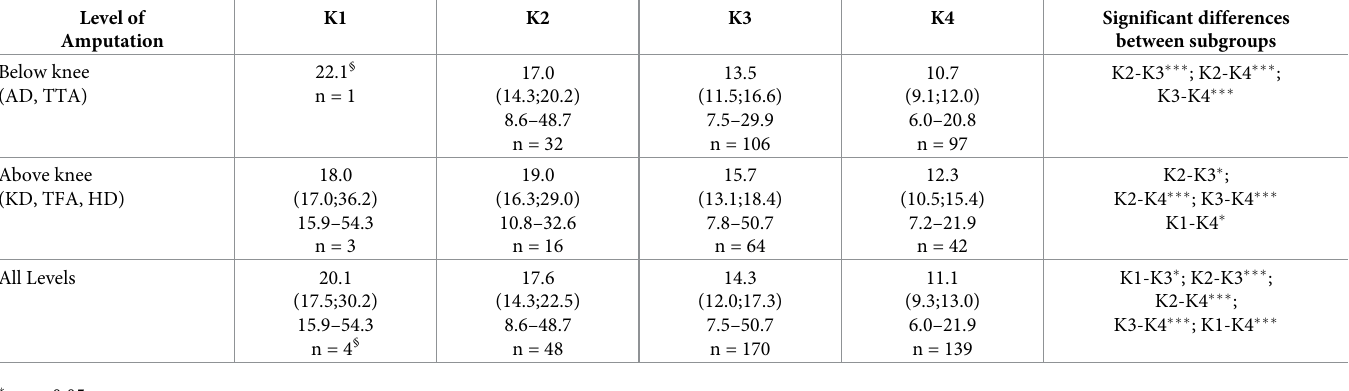
Table 5. The m5xSTS test times (seconds) by Medicare Functional Classification Level (K-level) and level of amputation (n = 361). Median and quartiles are provided for each subgroup in the following format: Median (75th quartile;25th quartile), minimum-maximum, and subgroup sample size. Level of